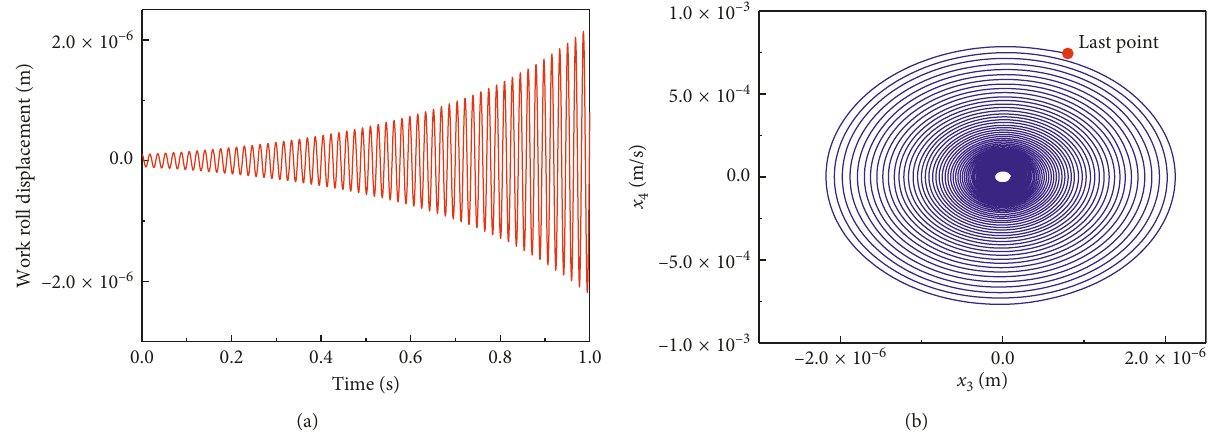
Figure 9: Dynamic response of the work roll displacement and the phase diagram under μ ∗ � 0 . 0420: (a) time history of work roll displacement; (b) phase